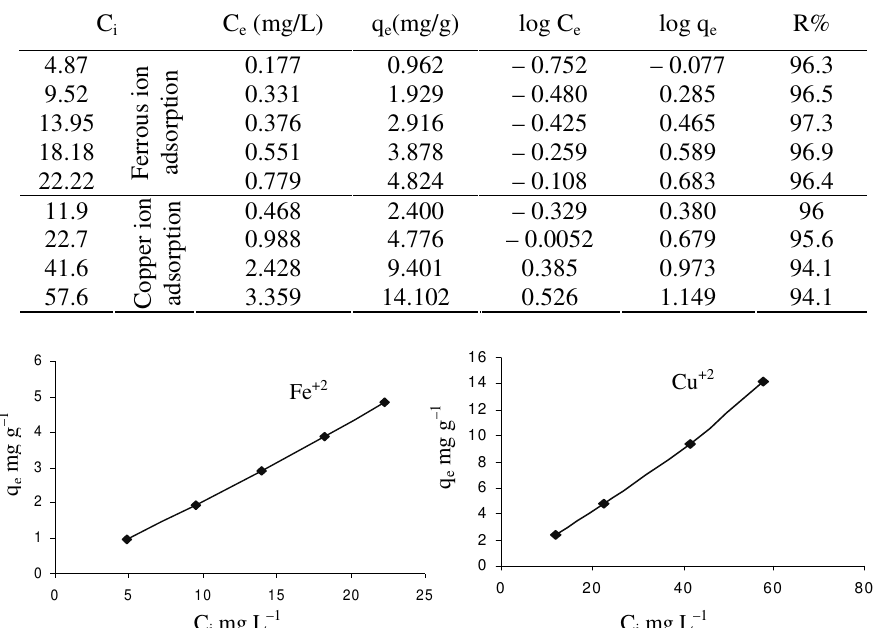
Table 4 . Equilibrium parameters for the adsorption of metal ions onto pine fruit powder at different initial concentrations.